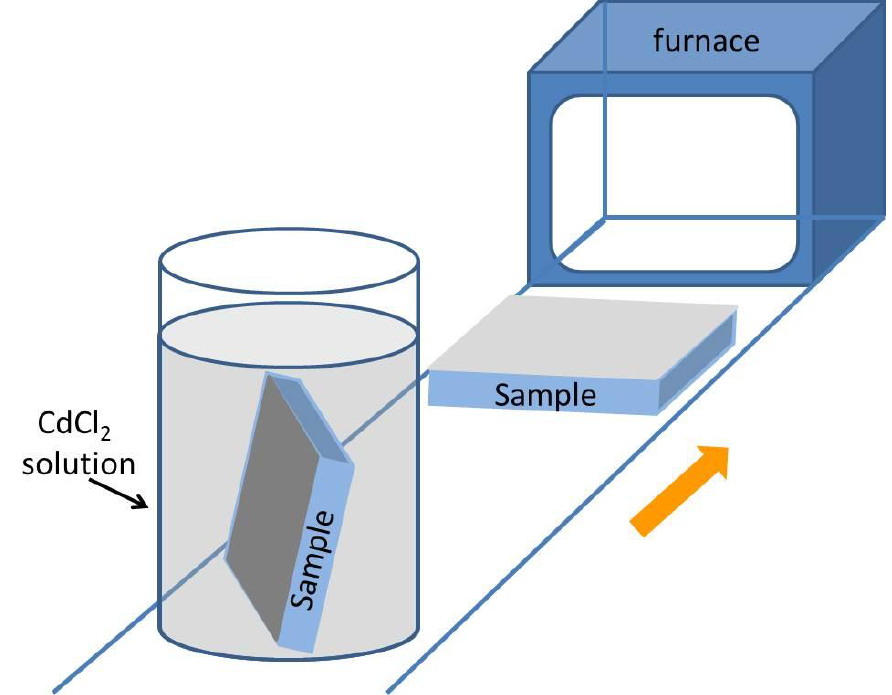
Figure 9. CdCl 2 deposition by methanol solution